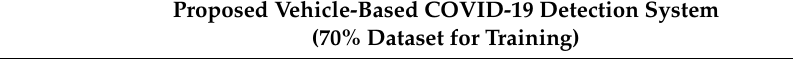
Table 2. Training of the suggested Vehicle-based COVID-19 Detection System (VCDS) during the prediction of